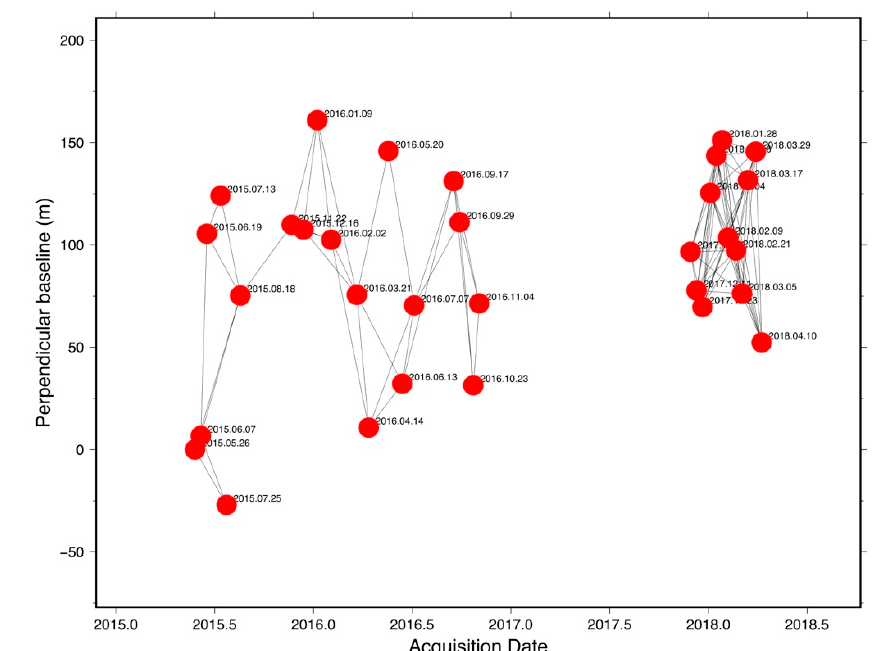
Figure 2. The perpendicular baseline of 96 interferograms (black lines) used in the Small Baseline Subset (SBAS) stacking of 31 of Sentinel-a images (red circle).